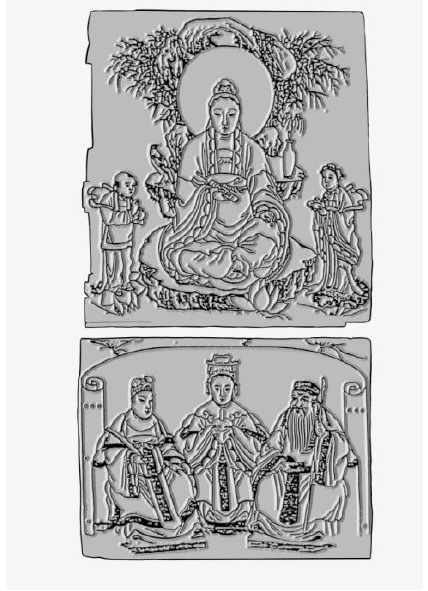
Figure 5. “Guanyin Malian” collected in the Wenying museum (double-layer composition).